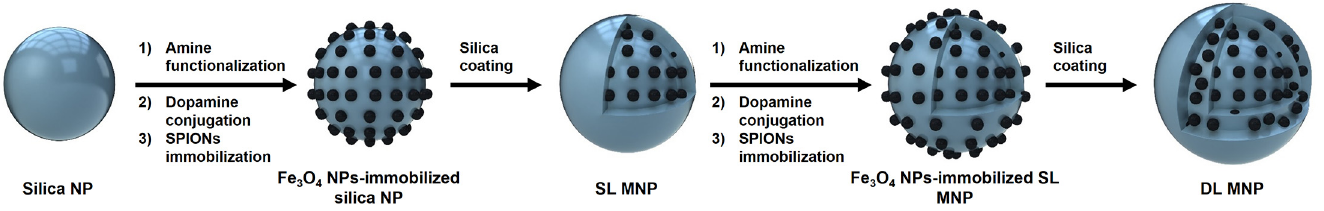
Fig 1. Synthetic scheme for the Fe 3 O 4 nanoparticles single-layered nanoparticles (SL MNPs) and double-layered nanoparticles (DL MNPs). Fe 3 O 4 NPs are immobilized to catechol-modified silica NPs; then, SL MNPs are prepared by silica-shell encapsulation. DL MNPs are prepared by repeating the aforementioned method to catechol-modified SL